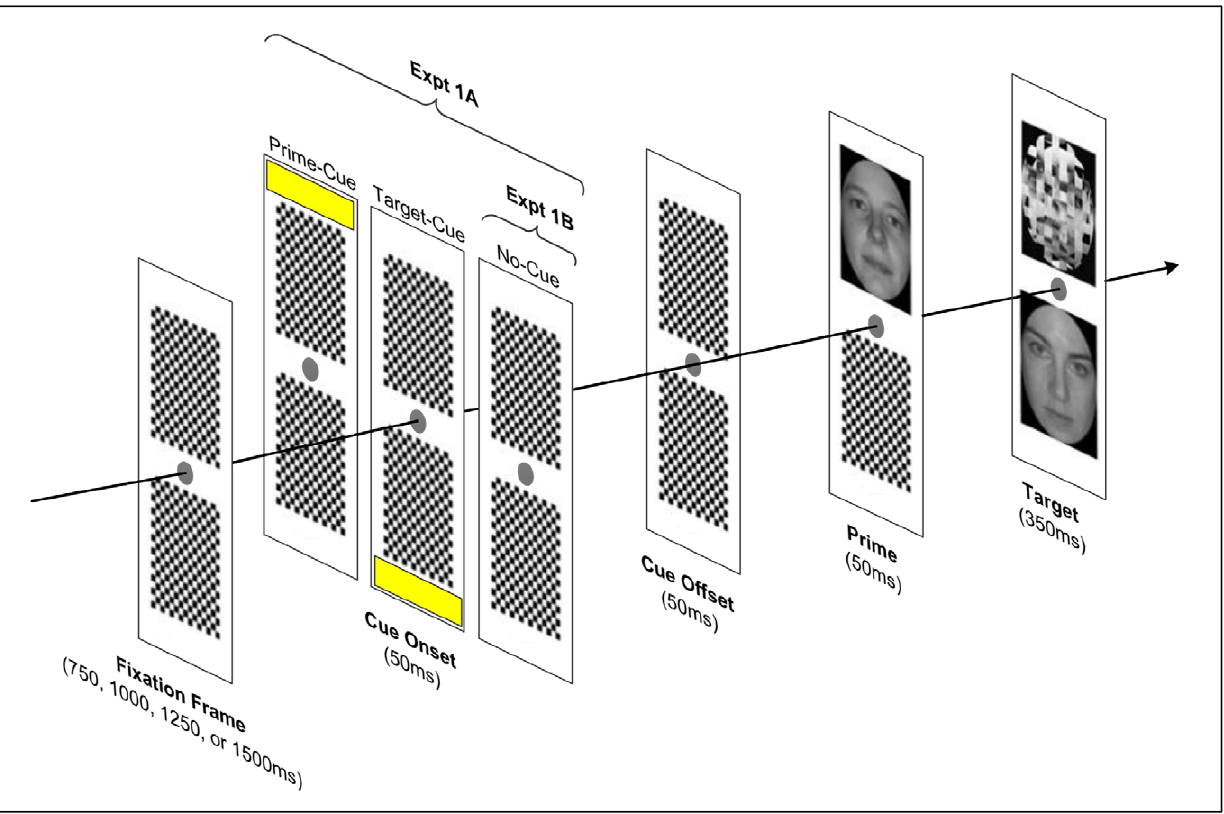
Figure 1. Trial structure for Expts 1A & 1B. Here we depict a congruent trial, in which the prime and target were of the same sex (i.e. female). Each frame consisted of two vertically displaced panels and a central fixation point, presented for identical durations within each frame. Prime and target items always appeared in the upper and lower panels respectively. Both experiments used a variable fixation duration (750 ms–1500 ms); in Expt 1A, the sudden onset and offset of a yellow bar captured participants’ transient spatial attention at the prime (upper) or target (lower) location. The individuals shown here provided written informed consent to the reproduction of their photographs in publication.